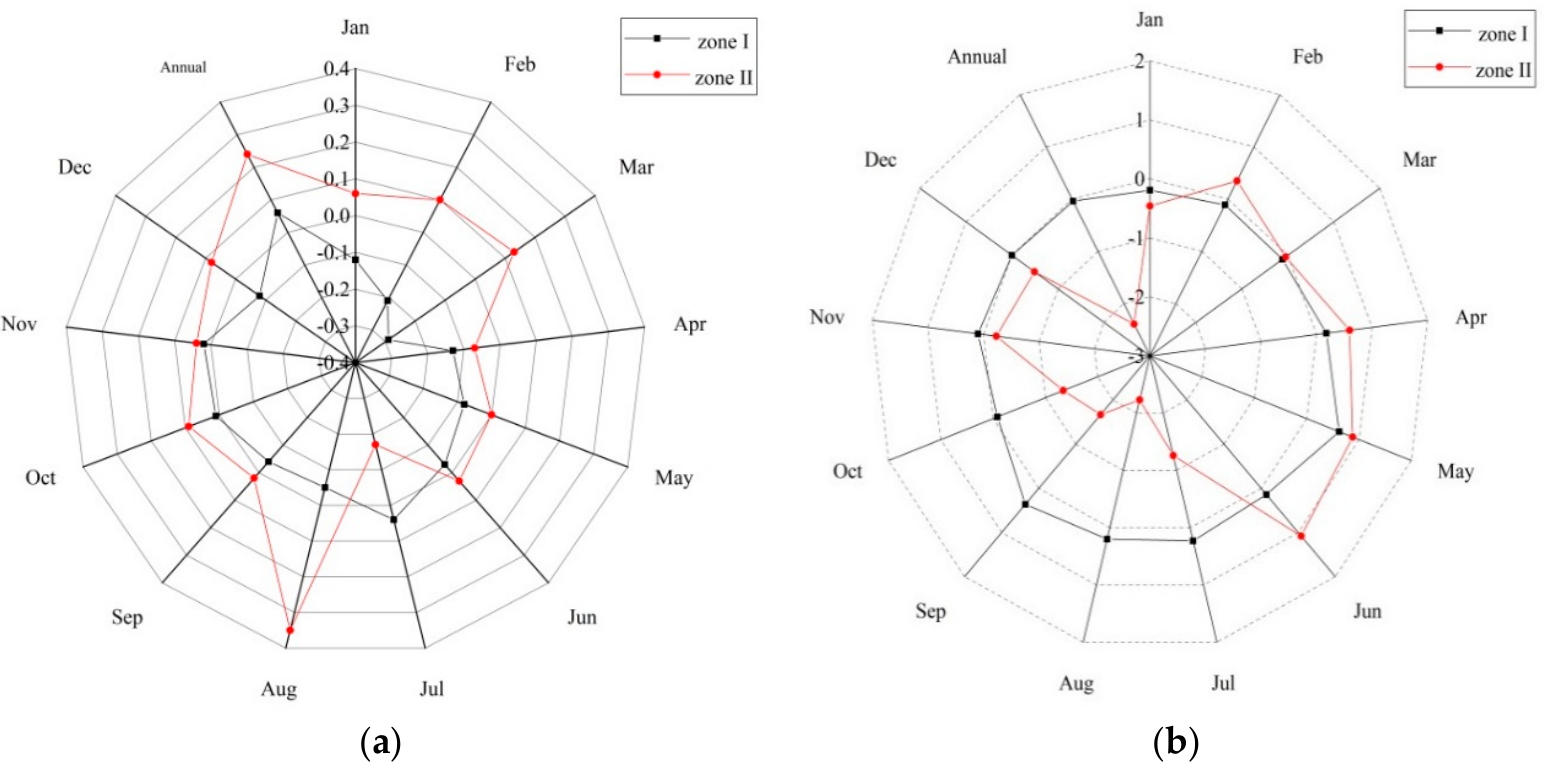
Figure 27. Precipitation and temperature sensitivity of both zones. ( a ) Precipitation sensitivity ( b ) temperature sensitivity.